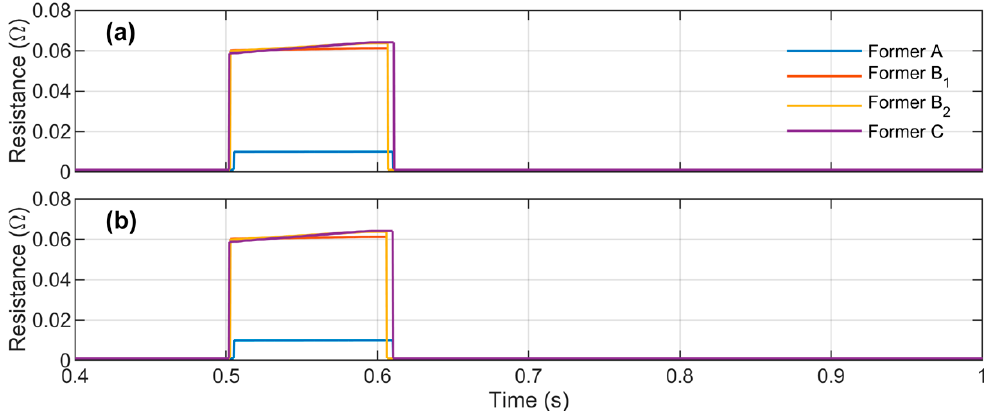
Figure 14. HTS cable resistances in case DCRs operate normally: ( a ) HTS 1 ; ( b ) HTS 2 .